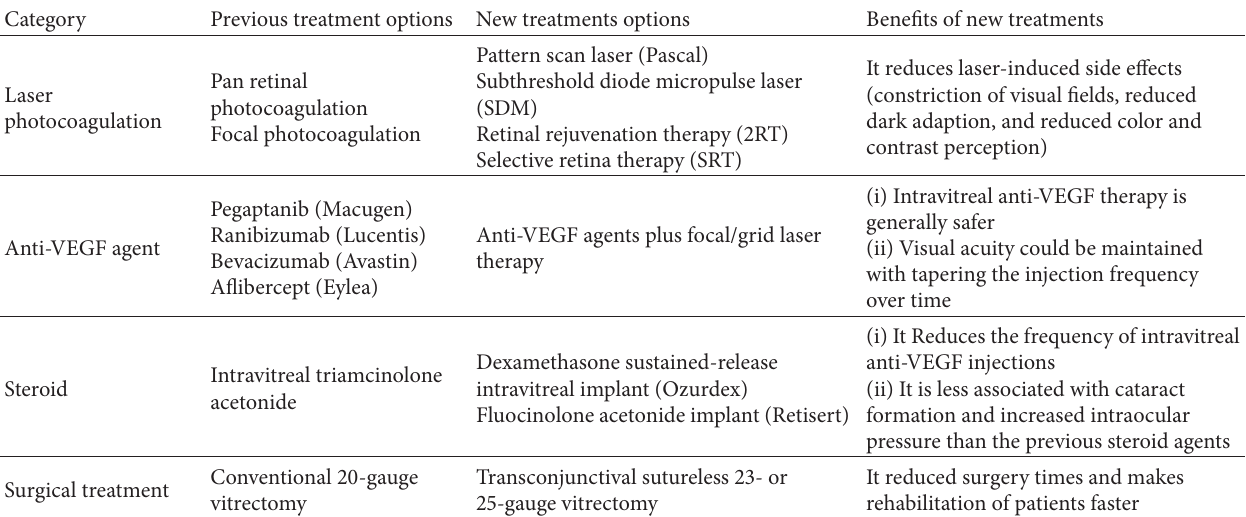
Table 1: Summary of current ophthalmic therapeutic options for diabetic macular